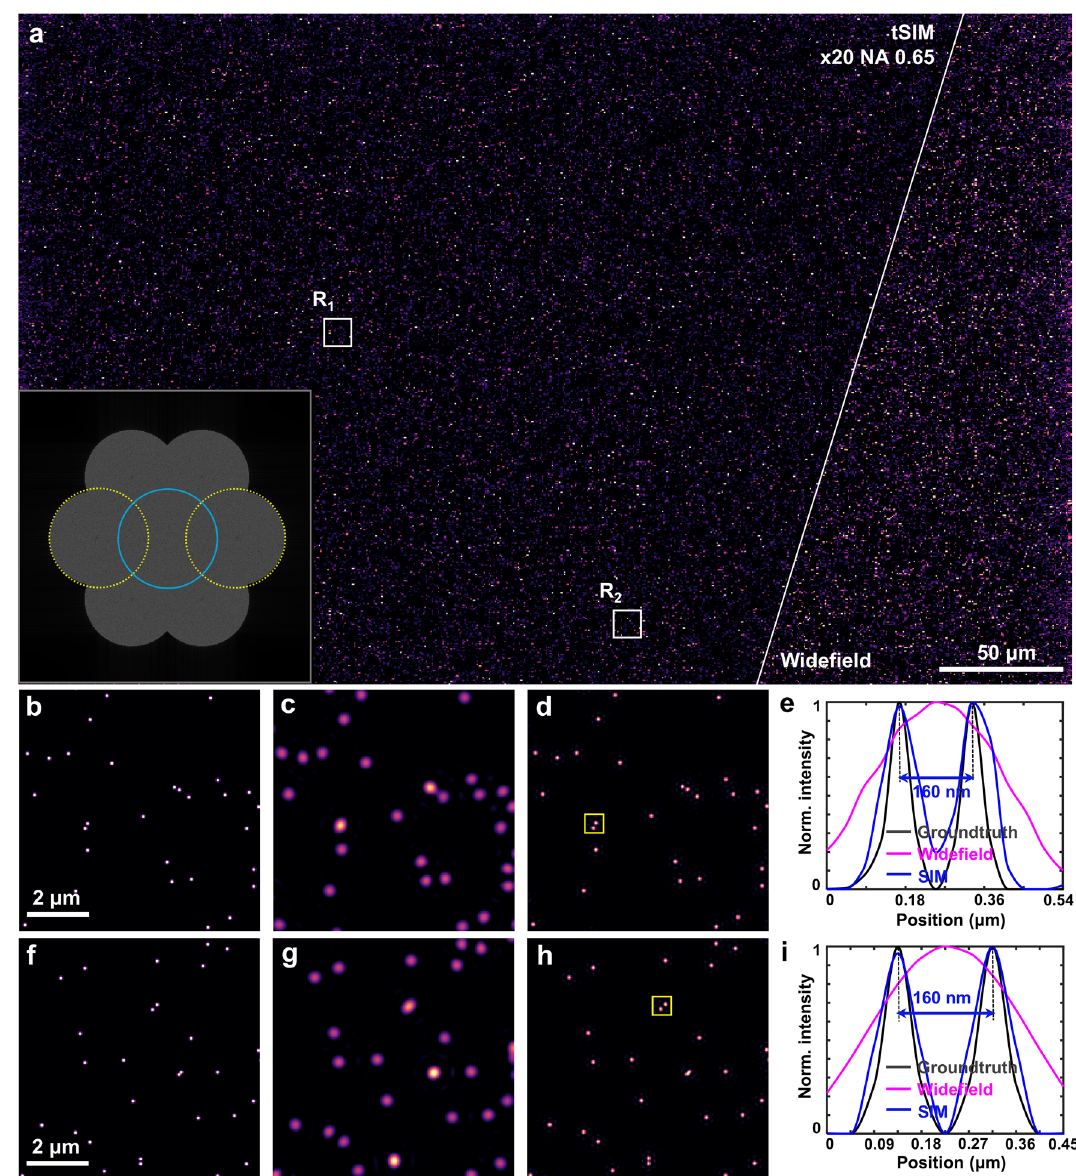
Figure 5. Simulation result of high-frequency tSIM imaging using synthetic fluorescent particles: ( a ) single FOV tSIM reconstructed image and widefield image using 20X/0.65 detection objective lens and inset shows spectra of the reconstructed image; ( b , f ) ground-truth object of R 1 and R 2 regions; ( c , g ) widefield image of R 1 and R 2 regions; ( d , h ) reconstructed image of R 1 and R 2 regions; ( e , i ) intensity line profiles within the yellow